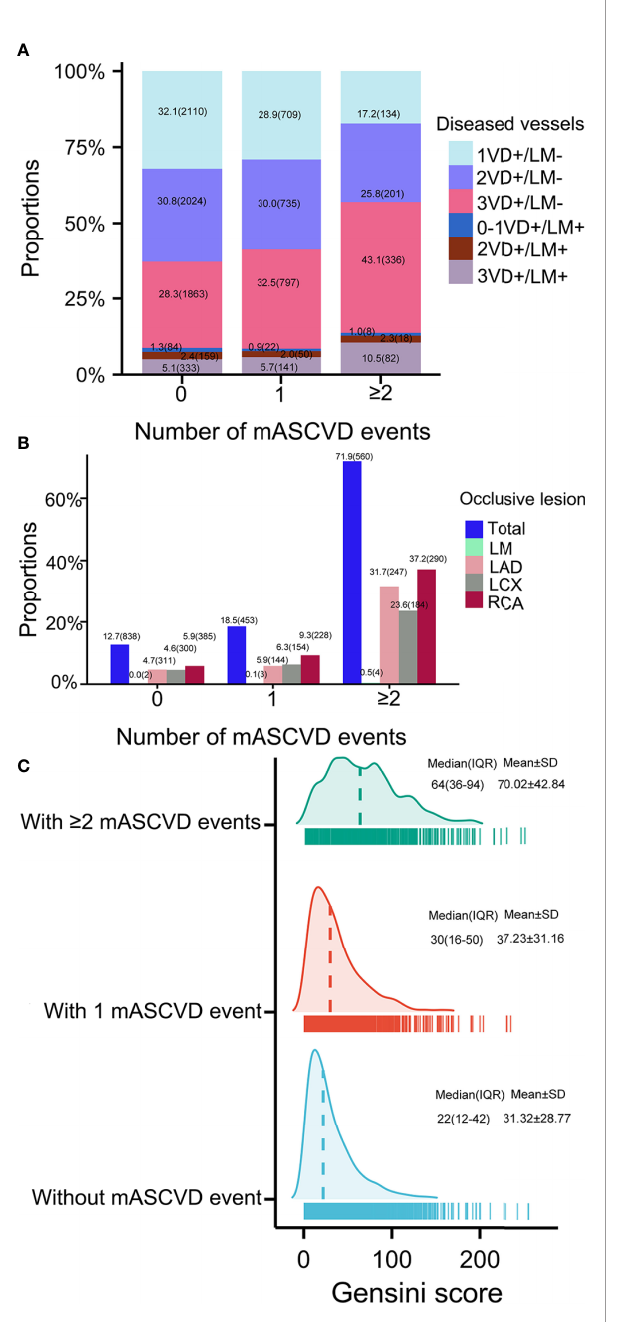
FIGURE 1 | Coronary severity according to number of mASCVD events. Coronary severity was assessed by (A) number of diseased arteries, (B) occlusive lesion, and (C) Gensini score. MASCVD, major atherosclerotic cardiovascular disease; VD, vessel disease; LM, left main; LAD, left anterior descending; LCX, left circum fl ex; RCA, right coronary artery.